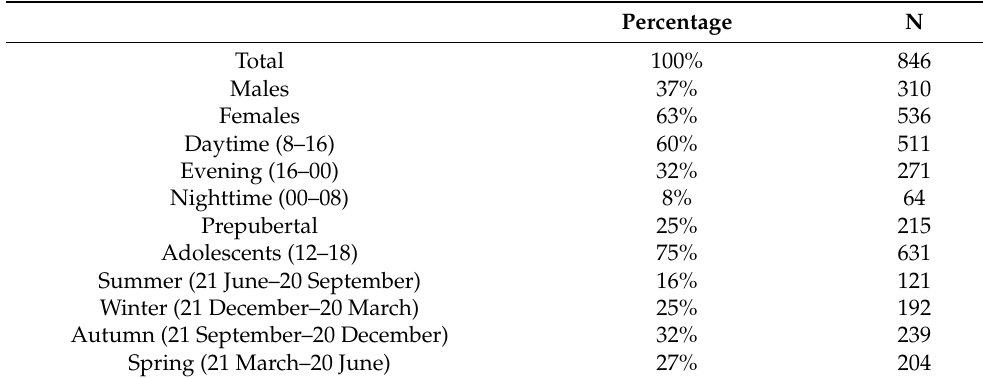
Table 1. Descriptive statistics of the sample characteristics.